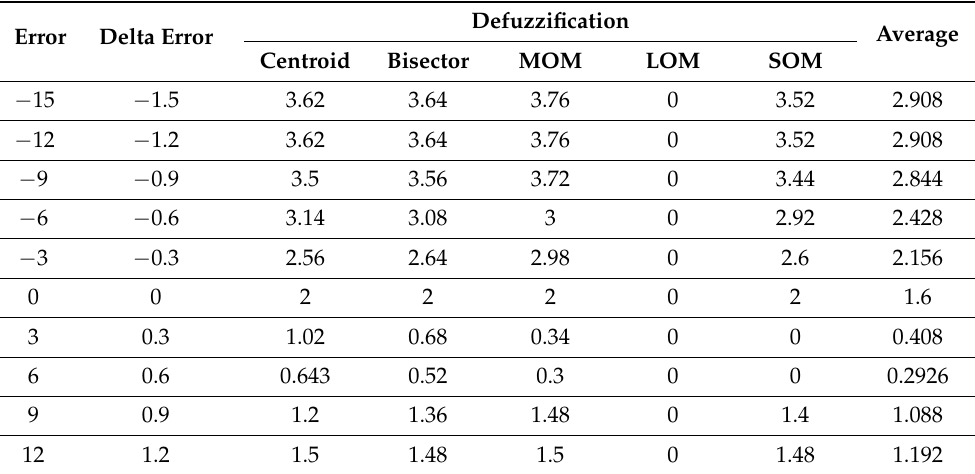
Table 1. Defuzzification.